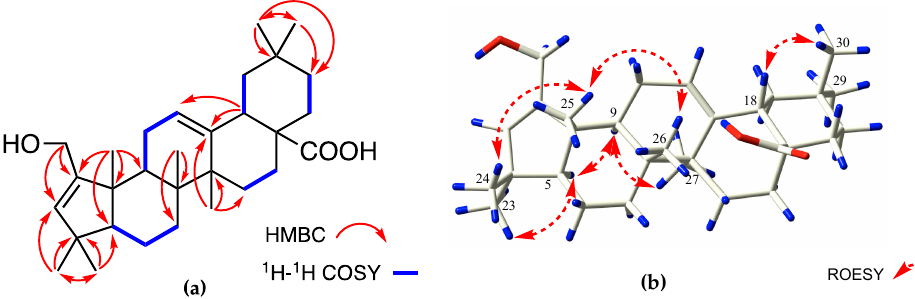
Molecules 2021 , 26 , x FOR PEER REVIEW 0.96, d (4.8) a: α -oriented proton. b: β -oriented proton. * Overlapped with the solvent peak. The relative configuration of 1 was ascertained through interpretation of its ROESY spectrum (Figure 2b). Based on the NOE correlations of H-5 with H 3 -9 and H 3 -23 and H-9 with H 3 -27, these protons were classified as α -oriented; the correlations of H 3 -25 with H 3 - 24 and H 3 -26 and H-18 with H 3 -30 revealed their β -orientation. To further elucidate its